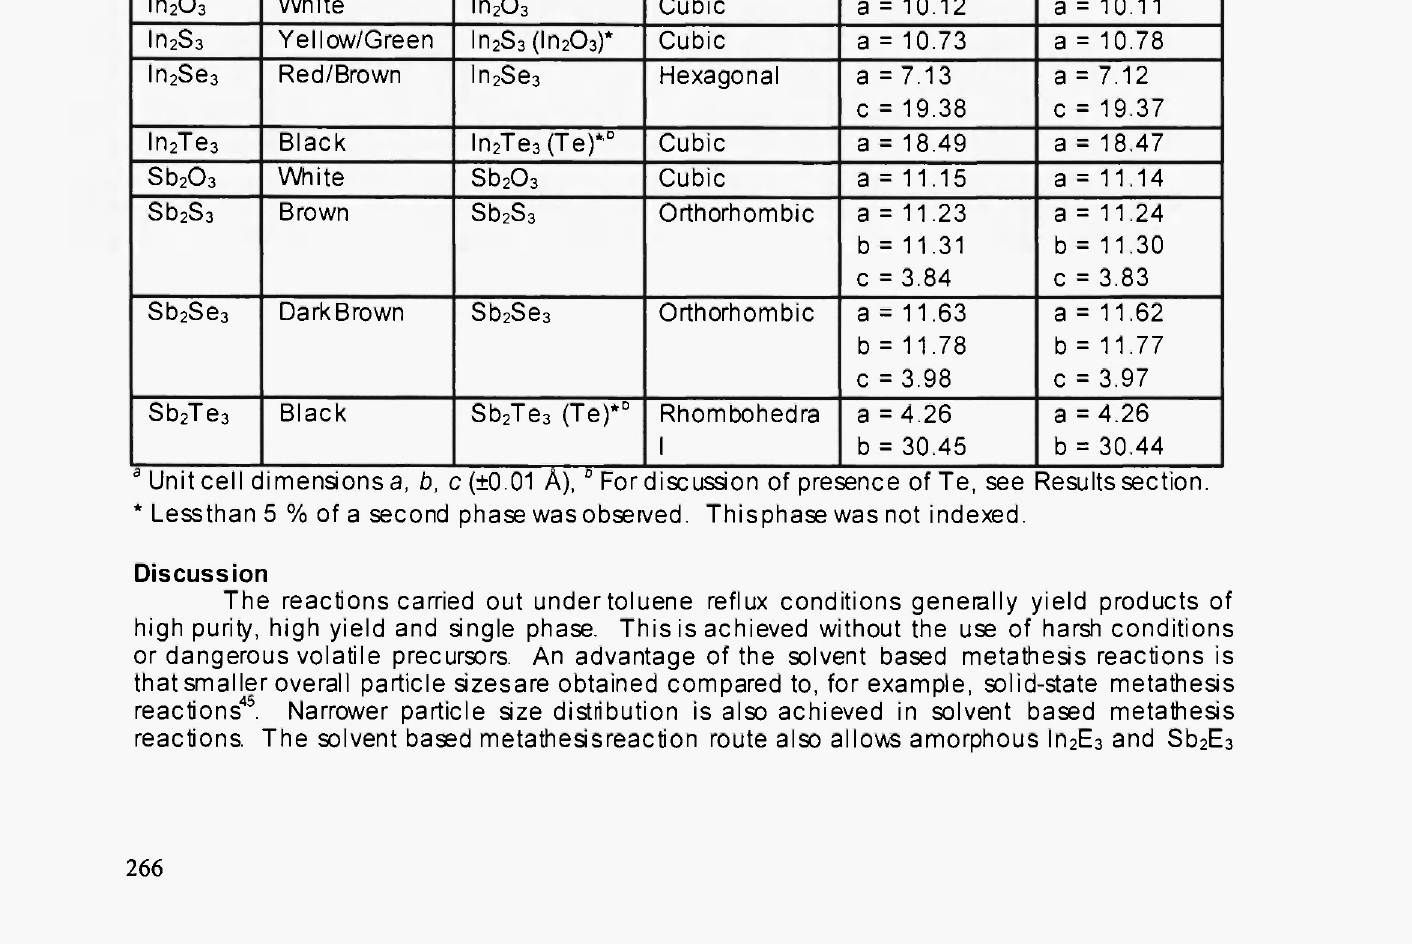
Fig. 3 - SEM micrograph of Fig. 4 - SEM micrograph of Fig. 5 - SEM micrograph of ln 2 0 3 (Before annealing) Sb 2 0 3 (Before annealing) Sb 2 Te 3 (Before annealing) (All micrographs have same scale; Scale bar = 4.3 μιτι, Mag. = 7000x) Table 1 : Compound description and X-ray powder diffraction data 3 from the reaction of MCI 3 (M = In, Sb) and Na 2 E or Na 2 0 2 in refluxing toluene for48 h.